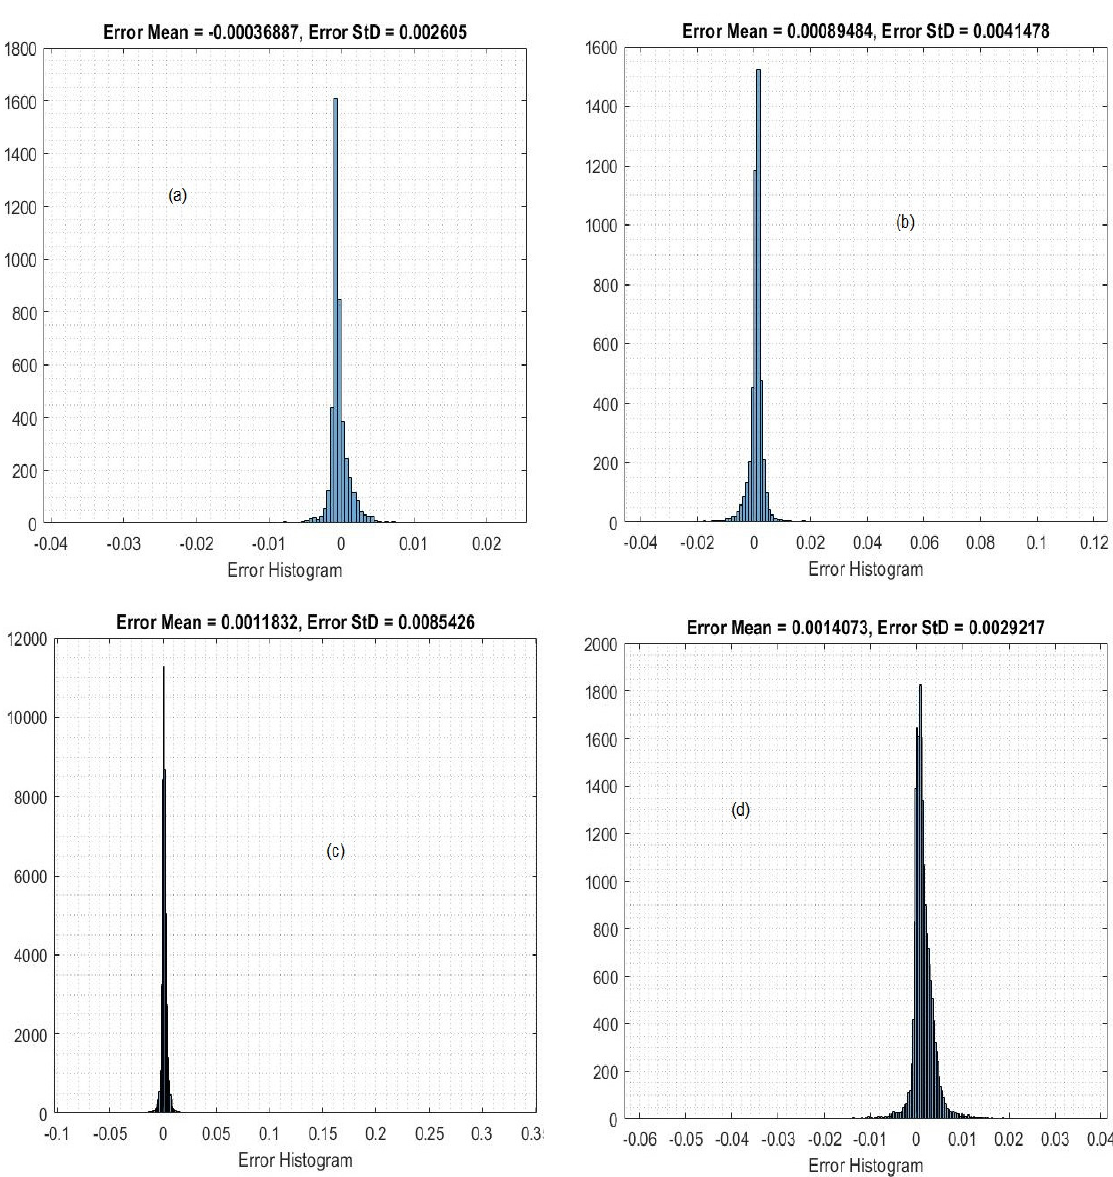
Figure 13. Histogram error of MLP in training testing, ( a ) communication ( b ) energy, ( c ) financial and ( d ) industrial sectors.